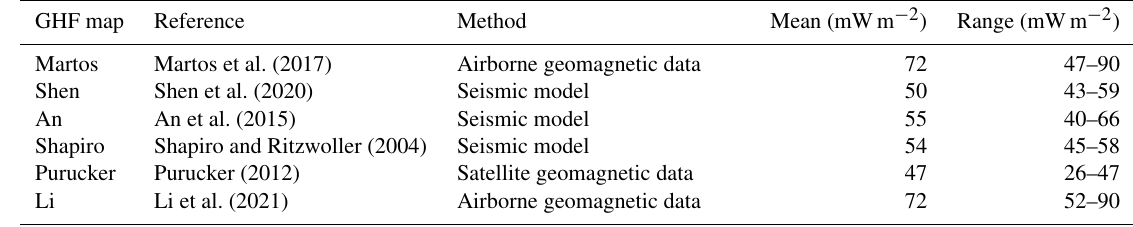
Table 2. The six GHF datasets used in this study.